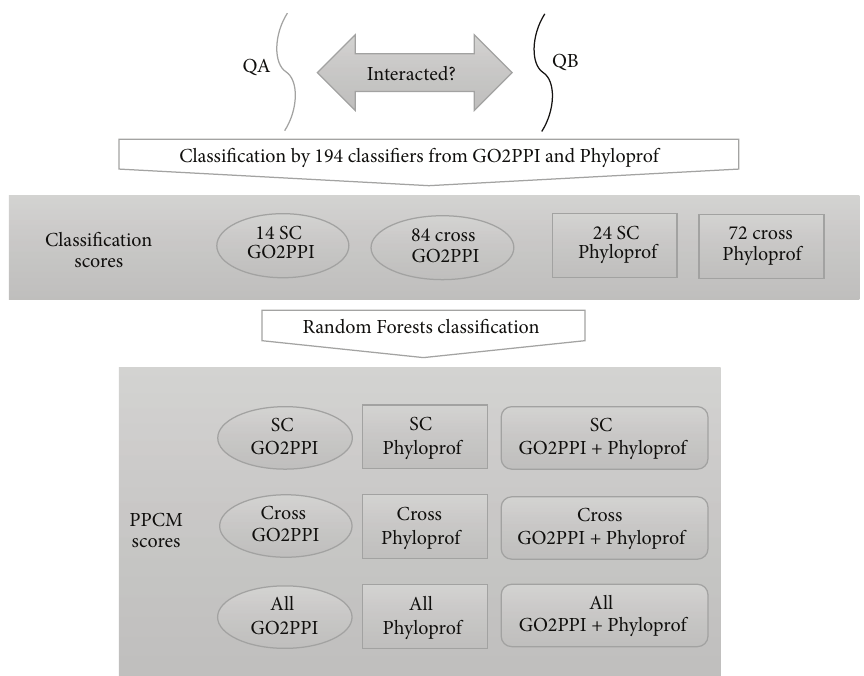
Figure 1: The PPCM pipeline for protein-protein interaction prediction. Given a pair of query proteins QA and QB, their interaction possibility was first predicted by each of the 194 classifiers from GO2PPI and Phyloprof. Then, the classification scores were merged using Random Forests algorithm to generate the final PPI prediction score. Nine PPI classification scores were provided by PPCM. “SC” represents PPI networks in Saccharomyces cerevisiae . “Cross” represents all PPI networks except SC. “All” represents all PPI networks in both SC and cross